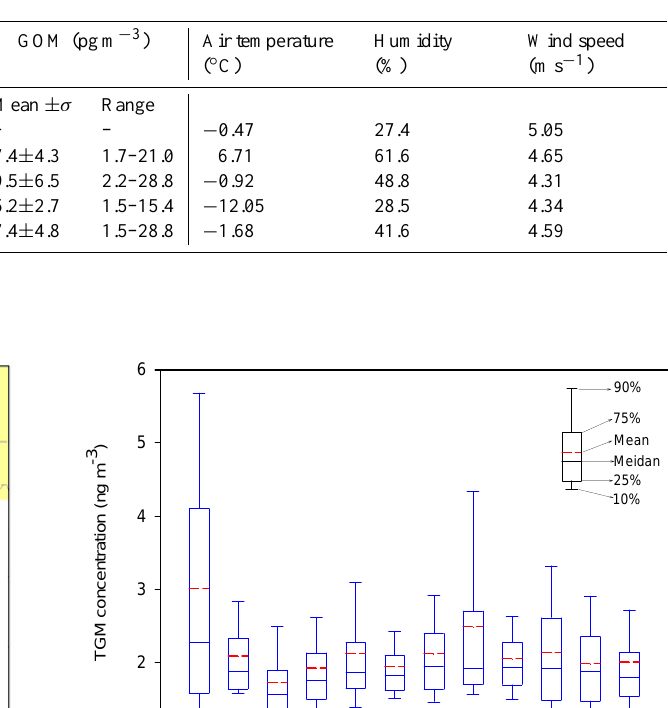
Table 1. Summary of speciated Hg concentrations and meteorological parameters from September 2007 to September 2008 at WLG.